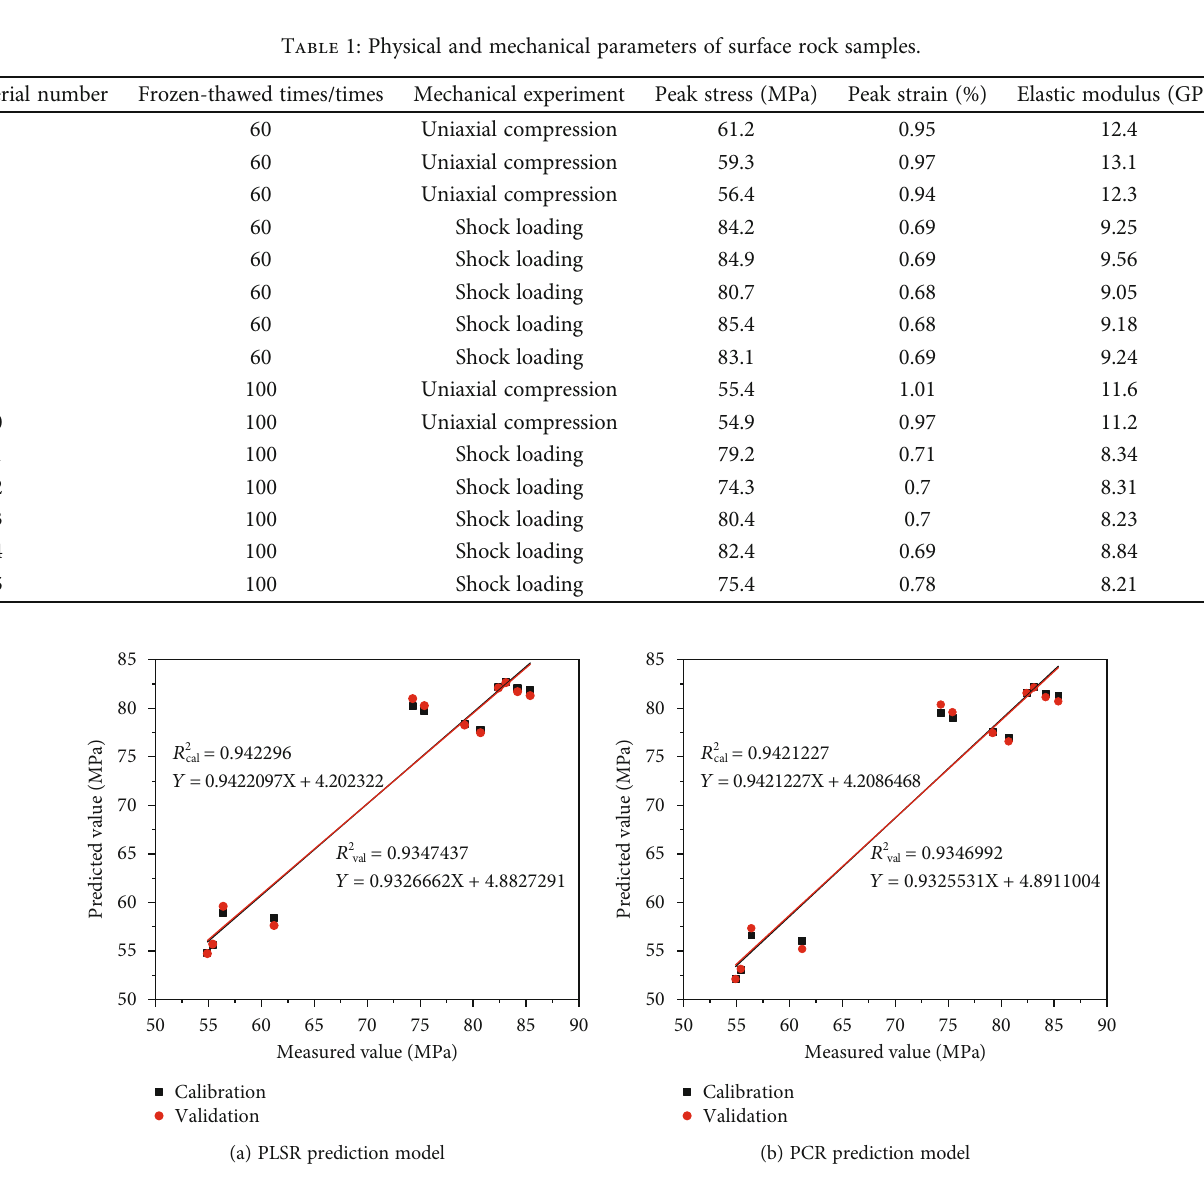
Figure 1: Correlation between the predicted values and measured values of PLSR and PCR prediction models for peak stress of frozen- thawed